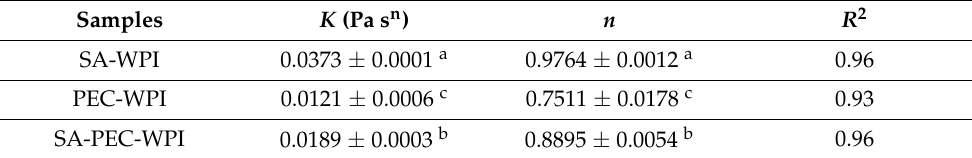
Table 1. Power-law parameters for the SA-WPI, PEC-WPI, SA-PEC-WPI stabilized β -carotene emulsions.